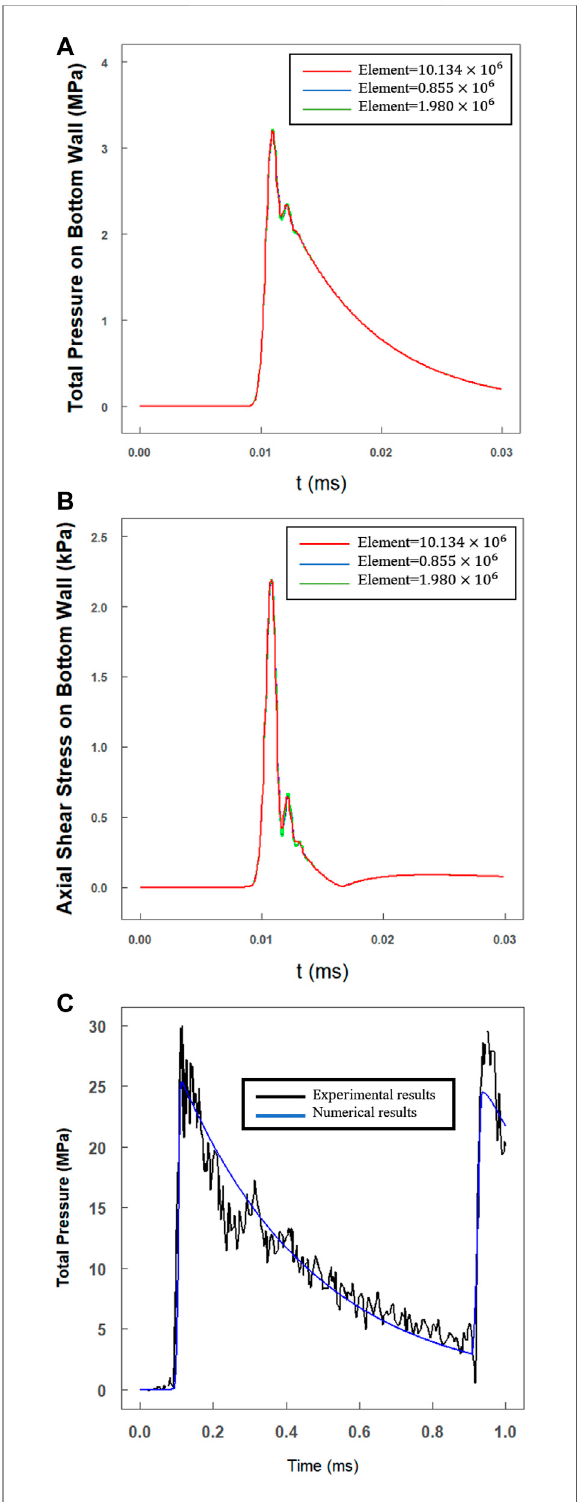
FIGURE 3 Mesh independence analysis and sample comparison results. The total mesh count for testing the independence were about 0 . 855 × 10 6 (blue line), 1 . 98 × 10 6 (green line), 10 . 134 × 10 6 (red line)elementsrespectively. (A) Thevariationsoftotalpressure